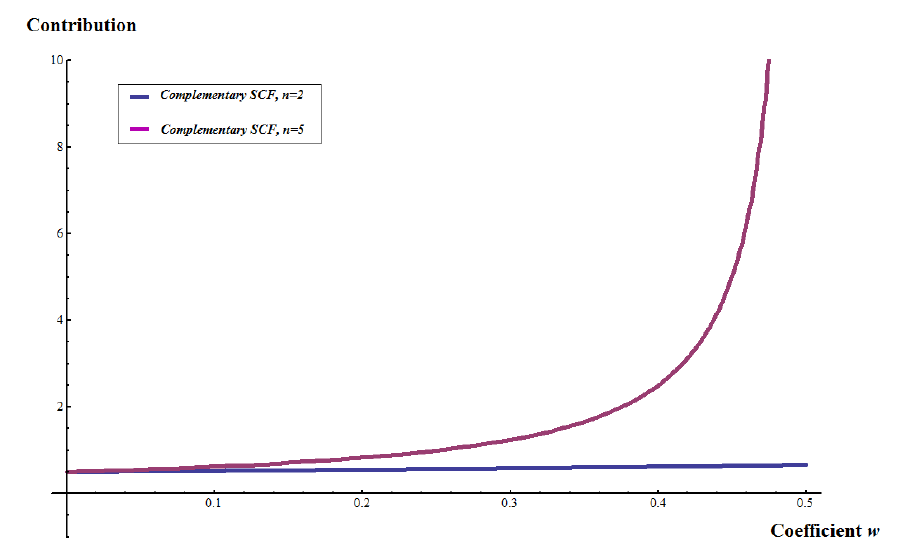
Figure 1. The equilibrium action as a function w in groups of five (red line) and two (blue line), e = 10, a = 19, b = 2 (complementary